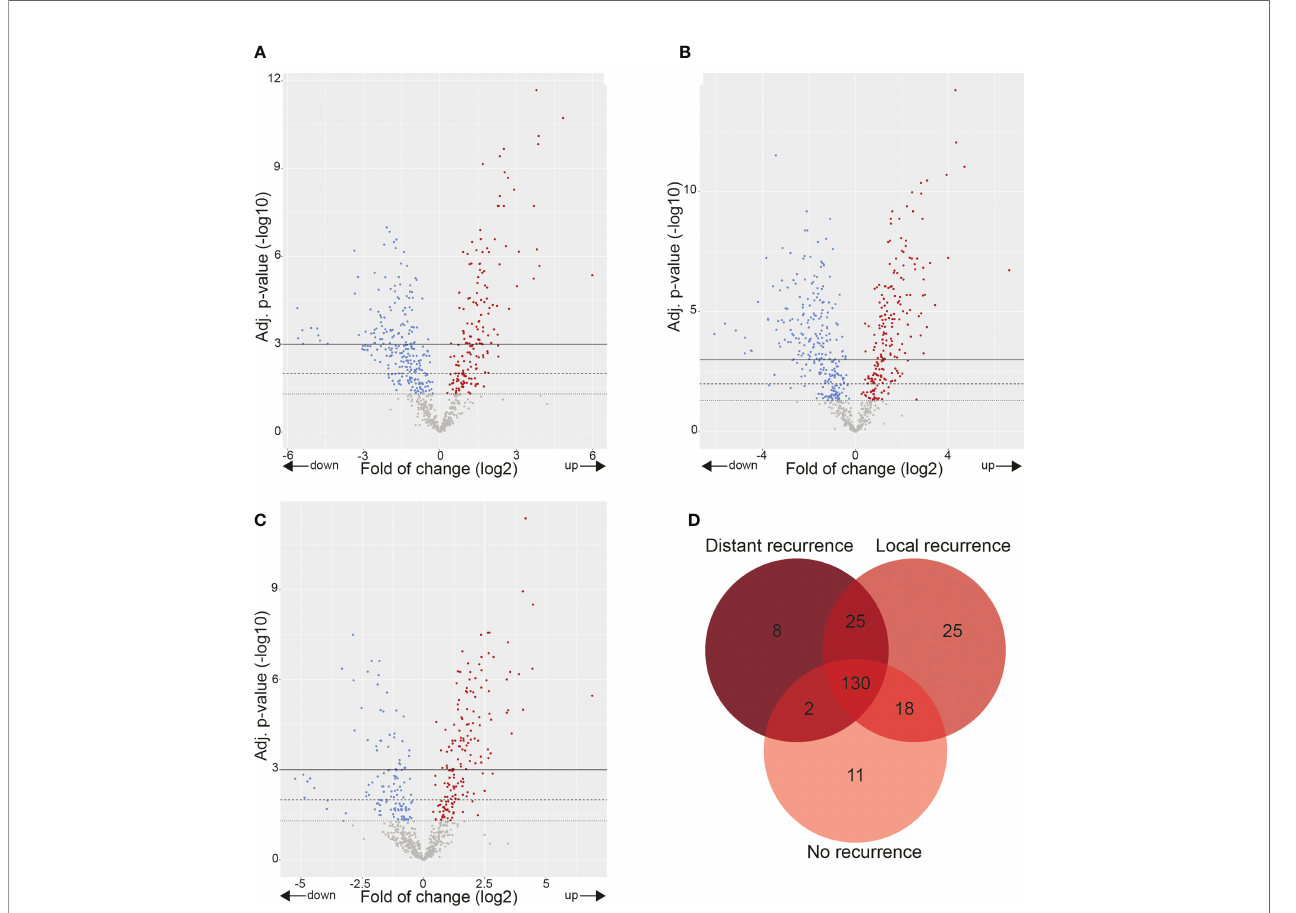
FIGURE 3 | Gene expression alterations in cervix tumors. Volcano plots showing over- and underexpressed genes in cervix tumors. Each dot represents a gene of the nCounter ® PanCancer IO 360 Gene Expression Panel. Y-axis: p-values after the Benjamini-Hochberg procedure (-log10 scale). X-axis: Fold of change is calculated with healthy controls as baseline reference (log2 ratio). (A) CCNR vs. healthy controls. (B) CCLR vs. healthy controls. (C) CCDR vs. healthy controls. (D) Venn diagram showing differentially overexpressed genes in CCNR, CCLR, CCNR relative to healthy controls. CCNR, Cervical cancer no recurrence; CCLR, Cervical cancer local recurrence; CCDR, Cervical cancer distant